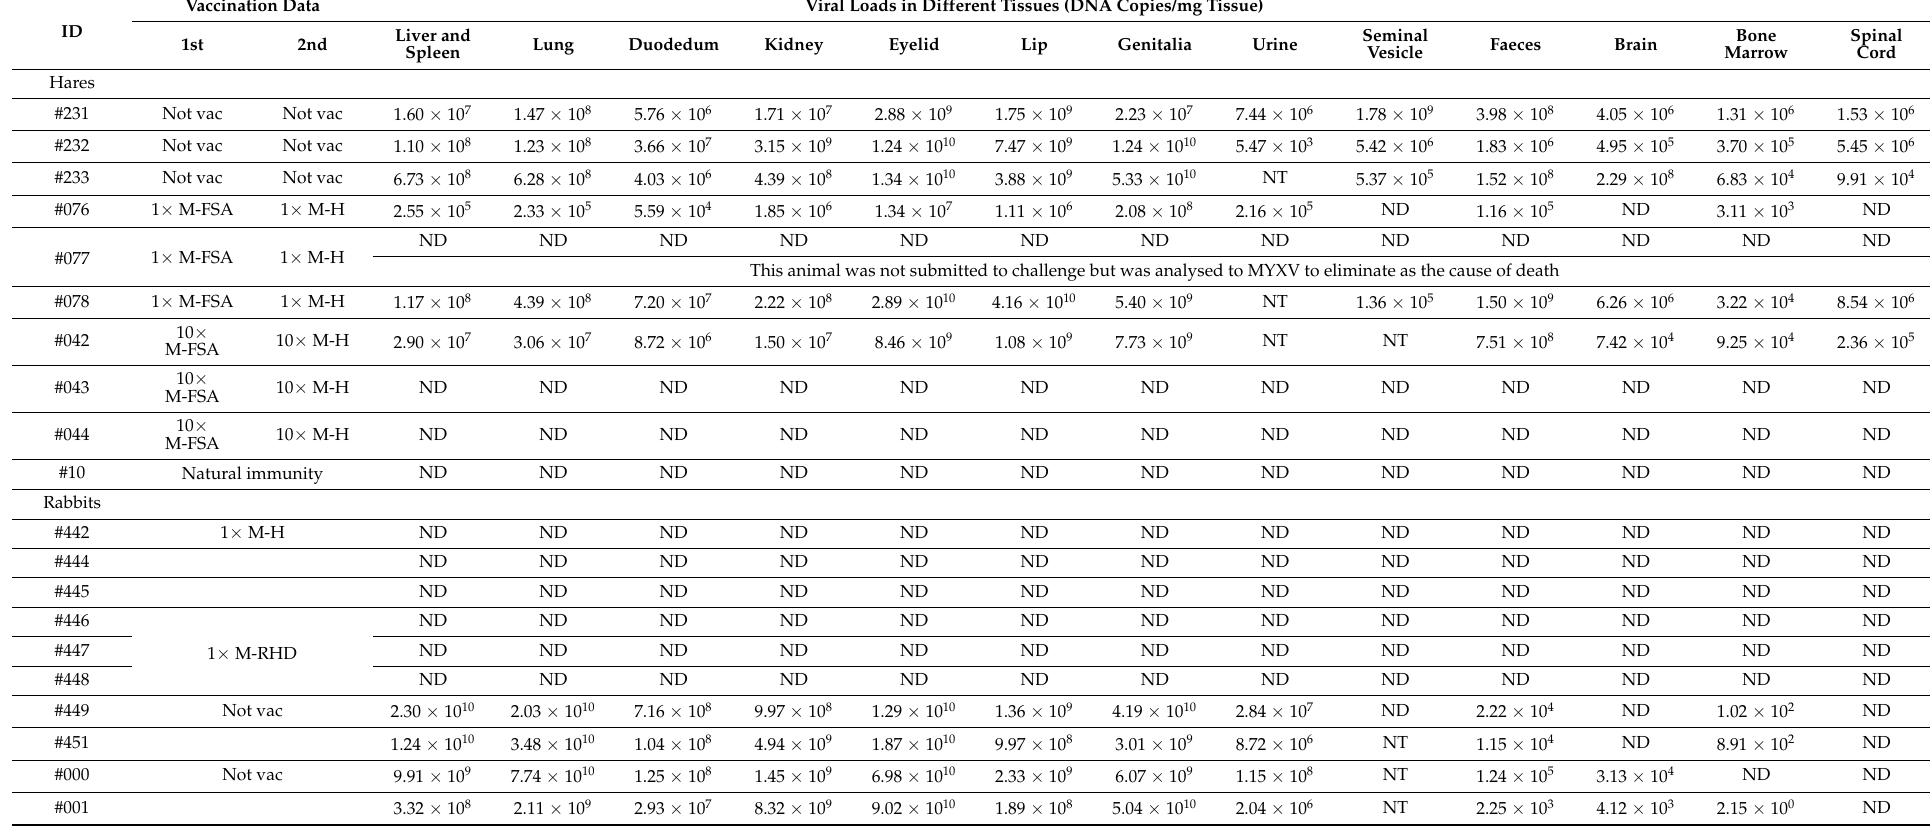
Table 6. Viral loads in the hare and rabbit tissues after